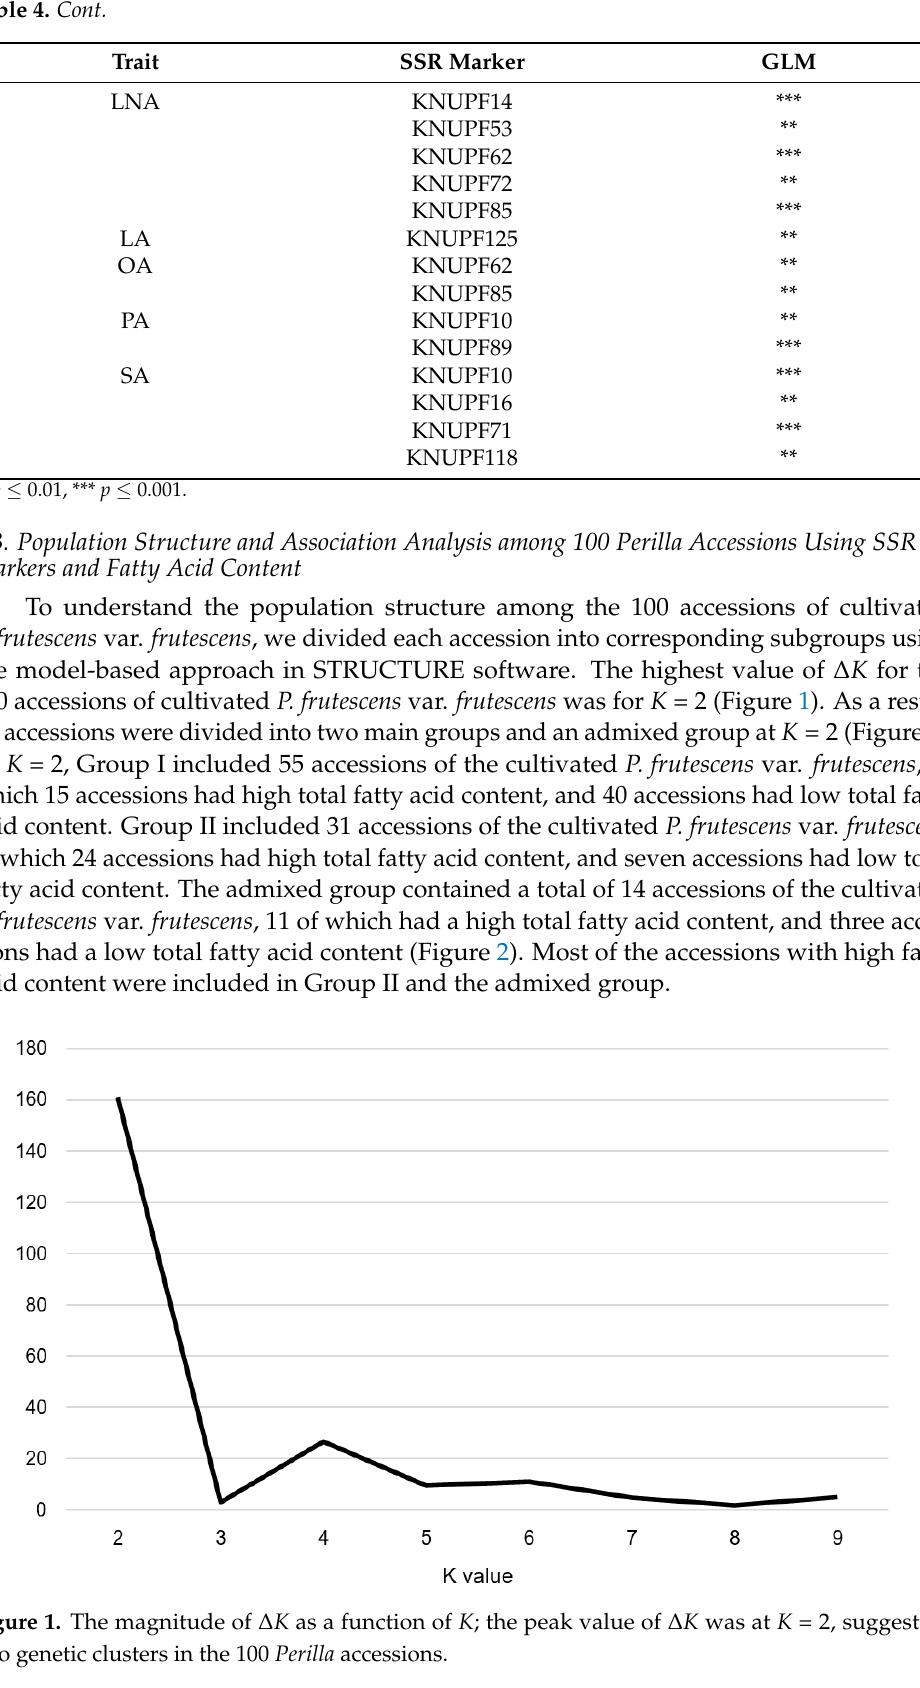
Figure 2. The population structure pattern for the highest Δ K value, K = 2, of 100 accessions of the cultivated var. frutescens based on 40 SSR markers. ○ : accessions of cultivated var. frutescens with a low total fatty acid content, ● : acces- sions of cultivated var. frutescens with high total fatty acid content. In addition, to select the SSR markers associated with the five fatty acids in the 100 accessions of cultivated P. frutescens var. frutescens , the genotypes of the 40 SSR markers and the Perilla seed oil traits, namely PA, SA, OA, LA, LNA, and TFAC, were used to confirm significant marker-trait associations (SMTAs) using TASSEL software. From the results, we detected 11 SSR markers (KNUPF10, KNUPF14, KNUPF16, KNUPF53, KNUPF62, KNUPF71, KNUPF72, KNUPF85, KNUPF89, KNUPF118, and KNUPF125) as- sociated with the six Perilla seed oil traits using a GLM at a significance level of p ≤ 0.01 or 0.001 (Table 4). Among the 11 SSR markers related to the Perilla seed oil traits, four SSR markers (KNUPF14, KNUPF62, KNUPF72, and KNUPF85) were associated with the TFAC trait at a significance level of p ≤ 0.01 or 0.001. Five SSR markers (KNUPF14, KNUPF53, KNUPF62, KNUPF72, and KNUPF85) were associated with the LNA trait at a significance level of p ≤ 0.01 or 0.001 (Table 4). Only one SSR marker (KNUPF125) was associated with the LA trait, with a significance level of p ≤ 0.01. Each of the OA and PA traits was associated with two SSR markers, KNUPF62 and KNUPF85, and KNUPF10 and